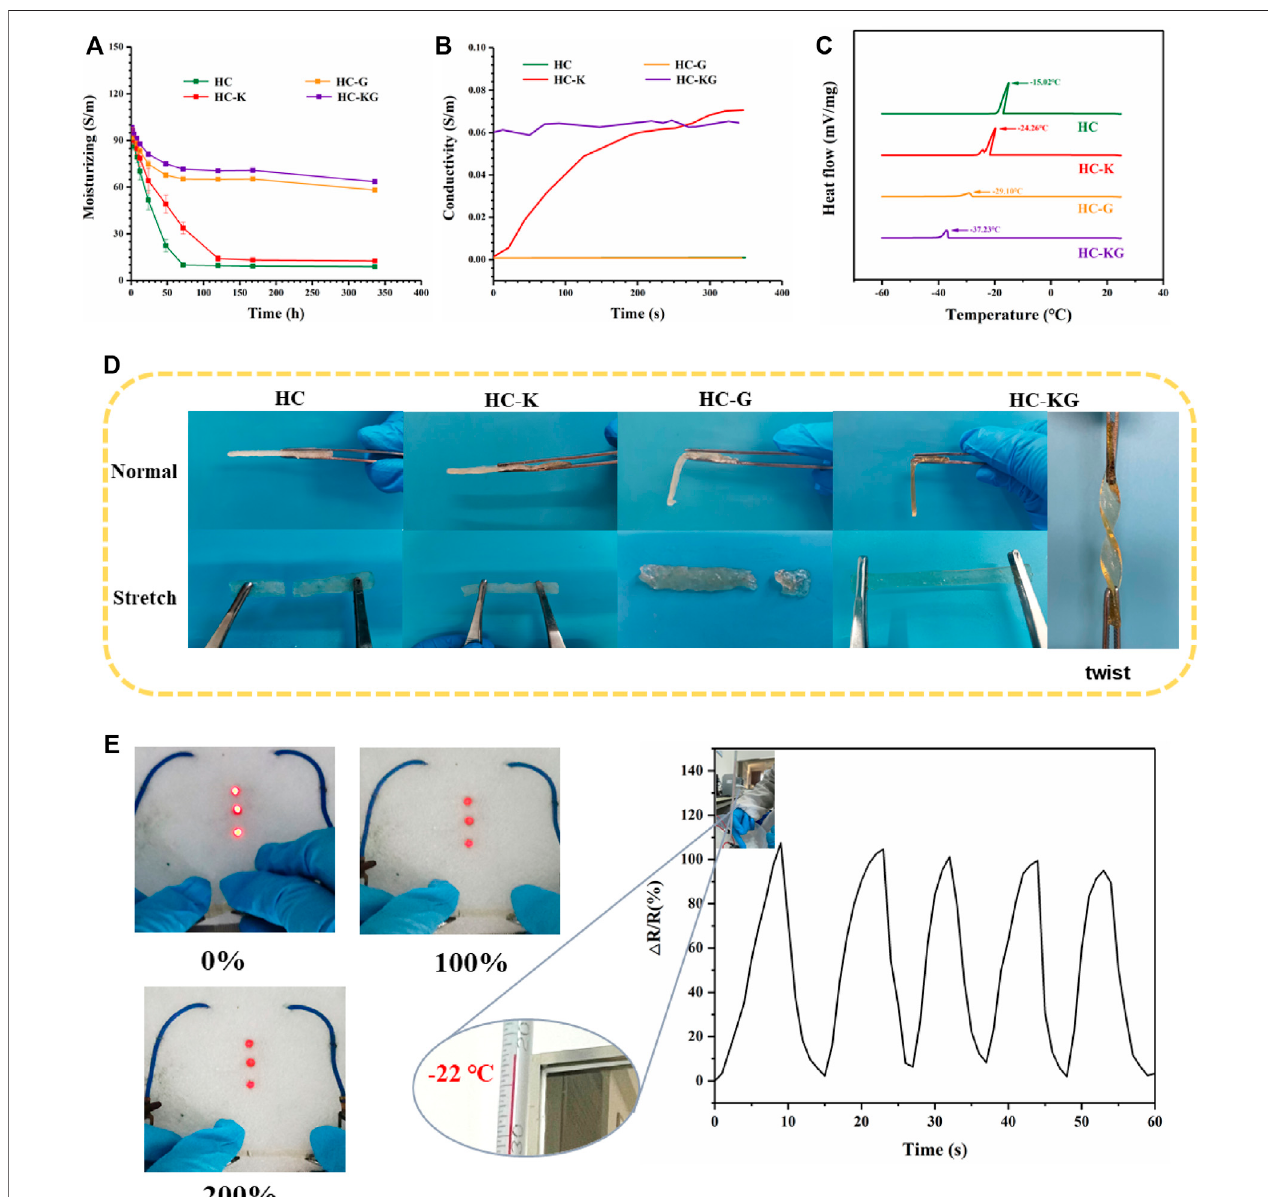
FIGURE 5 | Anti-drying and anti-freezing property of the HC-KG hydrogel. (A) Water content changing of HC, HC-K, HC-G, and HC-KG hydrogel under natural condition. (B) Conductivity as a function of time after transferring HC, HC-K, HC-G and HC-KG gel from a − 26 ° C refrigerator to a 25 ° C environment. (C) DSC curves of these four kinds of HA-ADH- and OCS-based hydrogel. (D) Flexibility comparison of HC-K and HC-KG hydrogel under − 26 ° C. (E) Conductivity of the HC-KG hydrogel with different elongation under − 26 ° C. ( F ) HC-KG hydrogel worked as the fl exible strain sensor under − 20 °